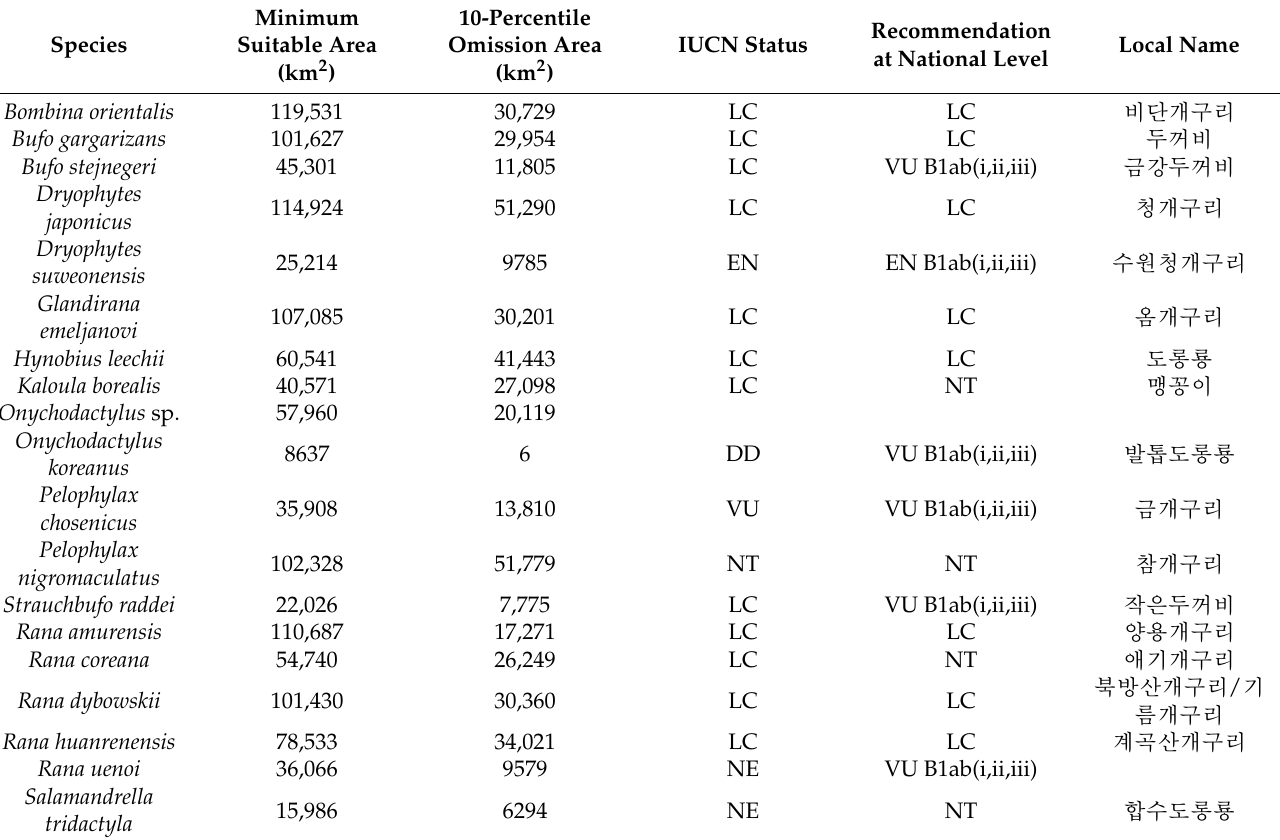
Table 5. Description of presence models used for each species in DPR Korea. The surface area in km 2 provided matches with the 10-percentile training and the 95% presence used in models. IUCN threat levels as of February 2019 (www.iucnredlist.org (accessed on 1 February